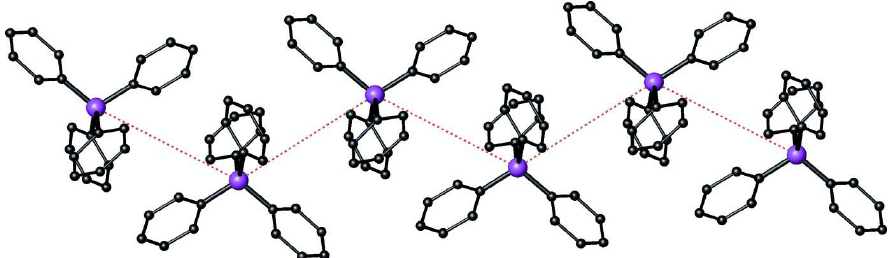
Figure 2 P] + cations, running along the b axis, illustrating the supramolecular edge-to-face phenyl interactions. Zigzag chain of [Ph 4 Short P···P distances ( ca 6.5 Å) are shown as red